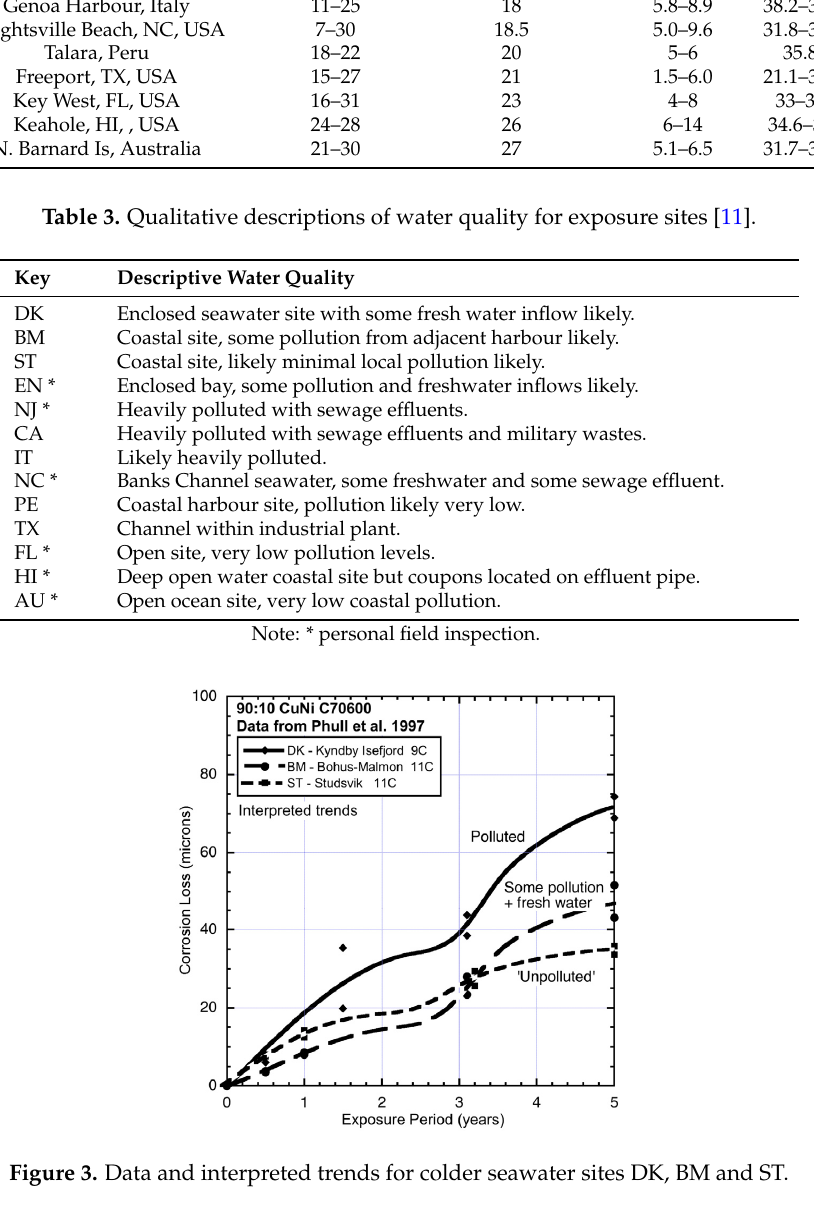
Figure 4. Data and interpreted trends for cool seawater sites EN and NJ. Figure 5. Data and interpreted trends for temperate seawater temperature sites CA, IT and NC.